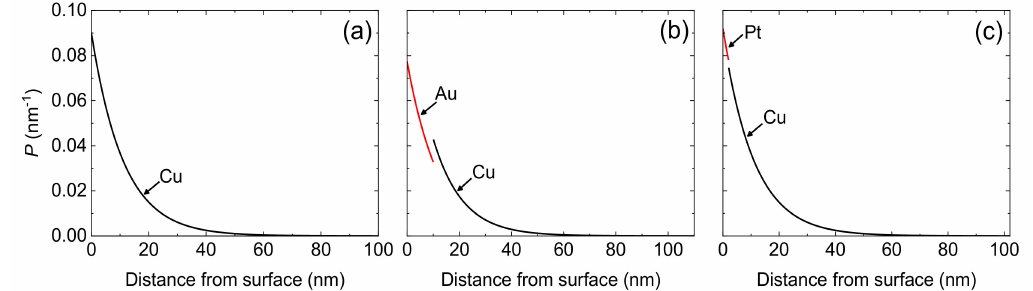
Figure 5. Thickness resolved magneto-optic Kerr effect (MOKE). Relative contribution to the Kerr rotation through the thickness of NM of the Pt(10)/FM(3.8)/NM structure, where NM is either ( a ) Cu(100), ( b ) Cu(100)/Au(10), or ( c ) Cu(100)/Pt(2). Black solid lines are the contribution from Cu, and red solid lines are the contribution from Au in ( b ) and from Pt in ( c